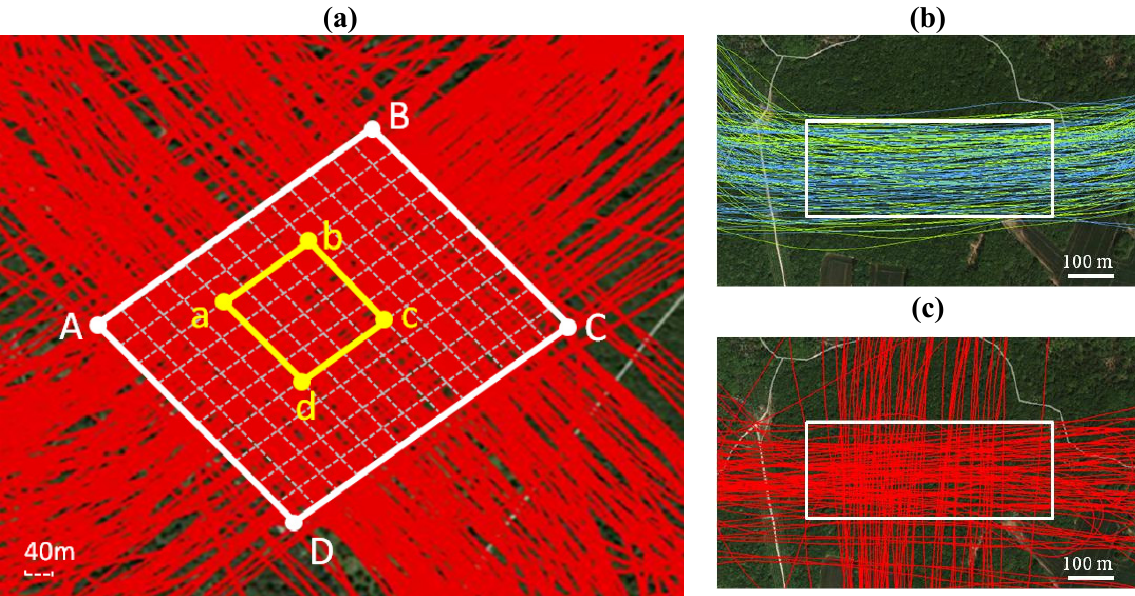
Figure 3. Flight tracks superimposed in color over the sampling sites (Google TM Earth). ( a ) Site 1 is at the crossing of winter 2010 flight tracks within the white rectangle ABCD. The well-documented central area is highlighted in the yellow rectangle abcd. The forest plots of 40 m × 40 m are bounded by white-gray dotted lines; ( b ) Flight tracks over the Site 2 in summer 2012; ( c ) Flight tracks over the Site 2 in winter